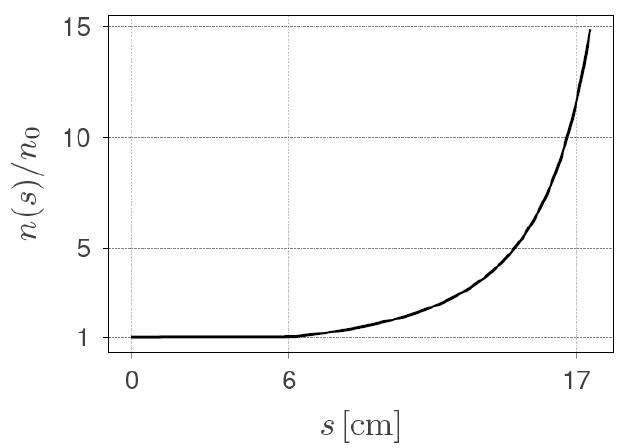
Figure 2. A tailored plasma density profile designed to eliminate the re-acceleration of particles in the bunch tail in the EuPRAXIA 1 GeV beam. The plasma density exhibits uniform behaviour until s = 6 cm, followed by a non-linear growth that reaches a 10 times higher density at s = 16.8 cm compared to the former uniform plasma density.